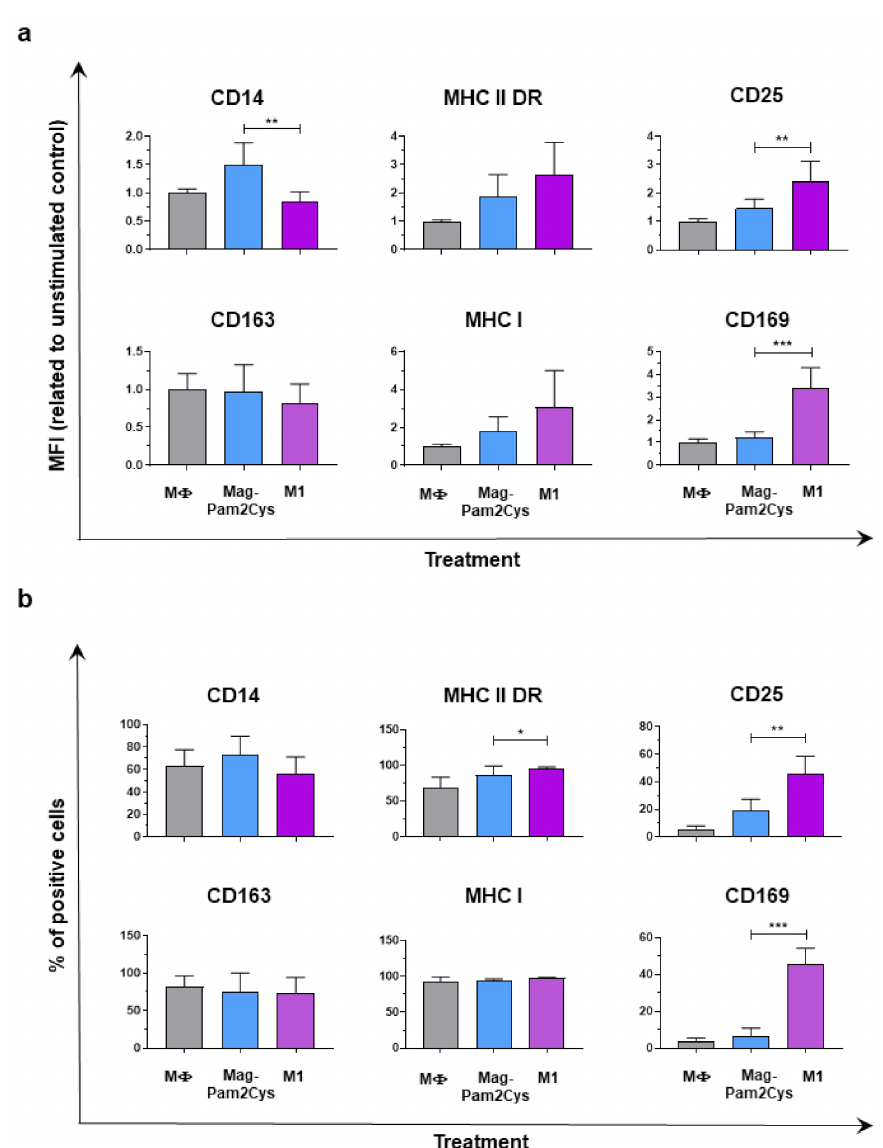
Figure 5. Modulation of moM Φ surface marker expressions by Mag-Pam2Cys and classical M1 polarizing factors. Porcine moM Φ were left untreated (M Φ ) or stimulated with Mag-Pam2Cys (100 ng/mL) or IFN- γ + LPS (M1). At 24 h post-stimulation, surface expression of CD14, MHC II DR, CD25, CD163, MHC I, and CD169 were assessed by flow cytometry. In Panel ( a ), mean fluorescence intensity (MFI) data are presented as fold-change relative to the untreated control (moM Φ ). In Panel ( b ), percentages of positive cells are shown. For both Panels, mean data and SD from three independent experiments using different blood donor pigs are displayed. Values of Mag-Pam2Cys- treated samples were compared to bona fide moM1 (M1), using a Mann–Whitney test. *** p < 0.001, ** p < 0.01, * p <